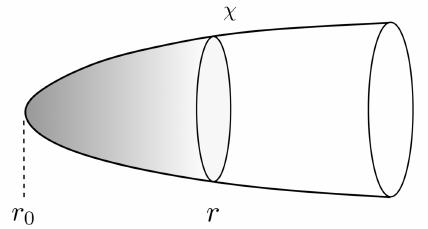
Figure 2 . We can estimate the expectation value of the winding condensate by considering a worldsheet that wraps the Euclidean black